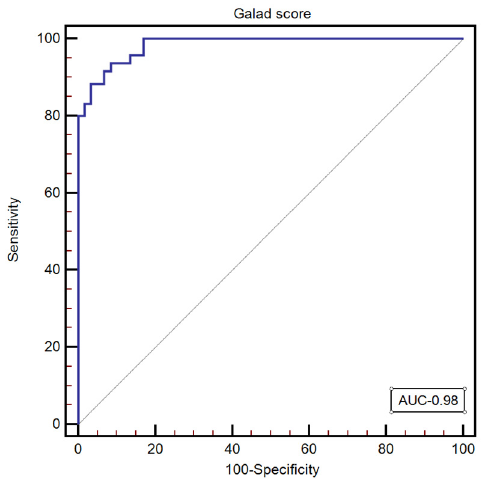
Figure 3. The performance of the GALAD score for predicting the presence of HCC.